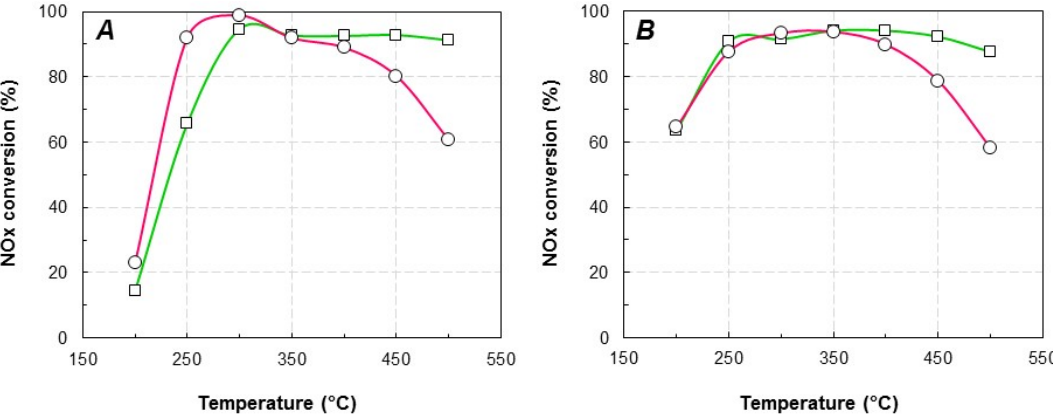
Figure 1. NO x conversion by NH 3 over Cu/FER ‐ exchanged zeolite. ( A ) standard ‐ SCR; ( B ) Fast ‐ SCR.